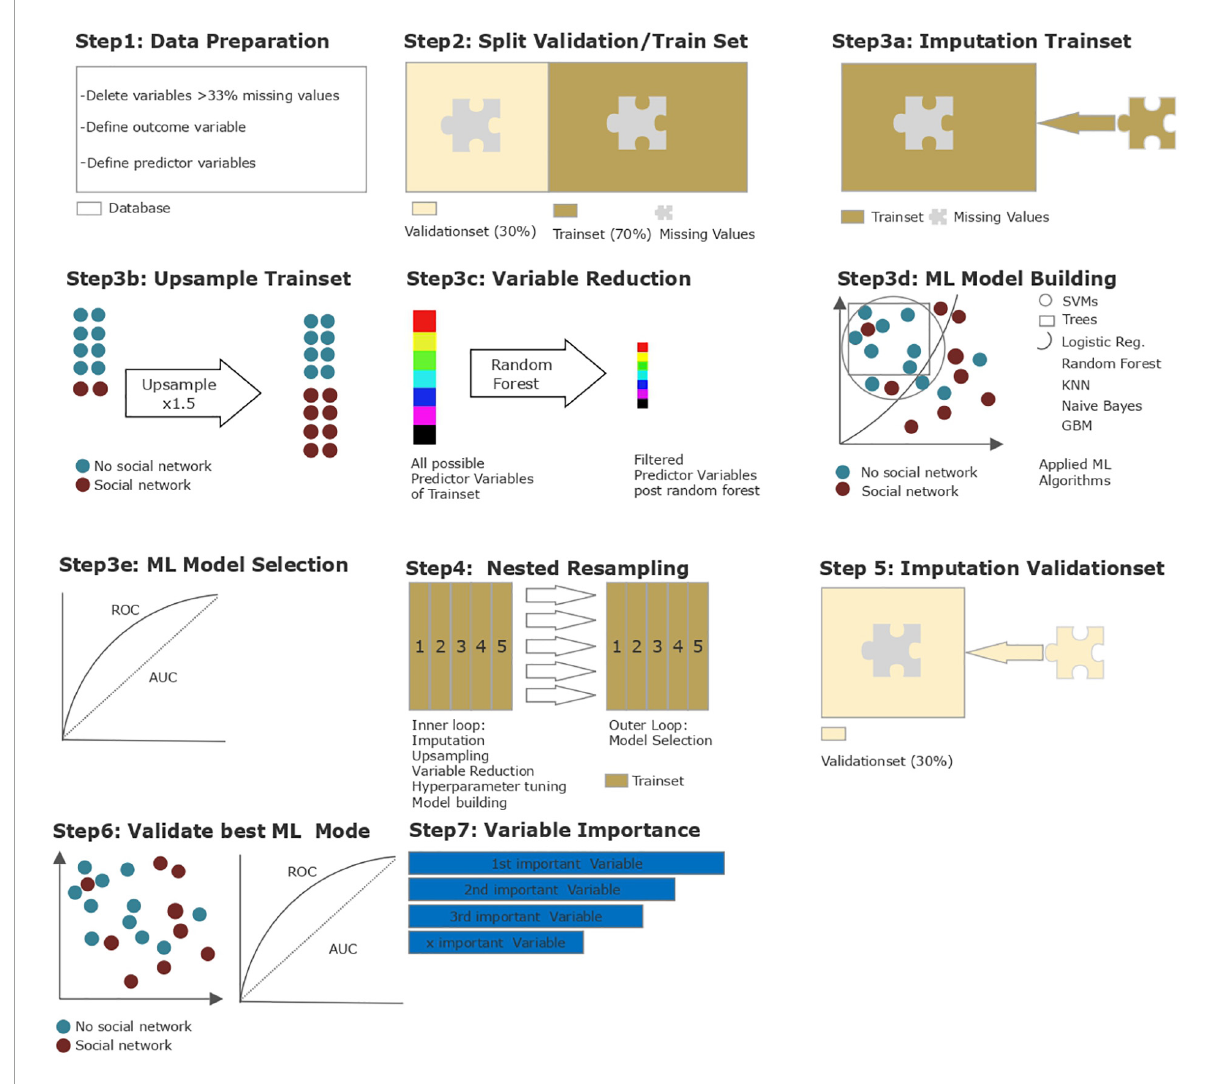
FIGURE1 Step 1—Data preparation : Multiple categorical variables were converted to binary code. Continuous and ordinal variables were not manipulated. Outcome variable violent behavior/no violent behavior and 507 predictor variables were defined. Step 2—Datasplitting : Split into 70% training dataset and 30% validation dataset. Step 3 a, b, c, d, e–Model building and testing on training data I : Imputation by mean/mode; upsampling of outcome “social network” x1.5; variable reduction via random forest; model building via ML algorithms—logistic regression, trees, random forest, gradient boosting, KNN (k-nearest neighbor), support vector machines (SVM), and naive bayes; testing (selection) of best ML algorithm via ROC parameters. Step 4—Model building and testing on training data II : Nested resampling with imputation, upsampling, variable reduction and model building in inner loop and model testing on outer loop. Step 5–Model building and testing on validation data I : Imputation with stored weights from Step 3a and upsampling of outcome “social network” x2. Step6—Model building and testing on validation data II: Best model identified in Step 3e applied on imputed and balanced validation dataset and evaluated via ROC parameters. Step 7— Test for multicollinearity and ranking of variables by indicative